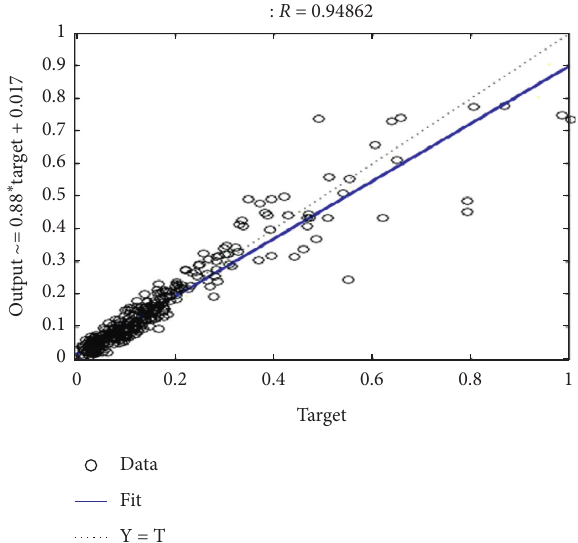
Figure 9: Performance regression plot of the ANNPSO